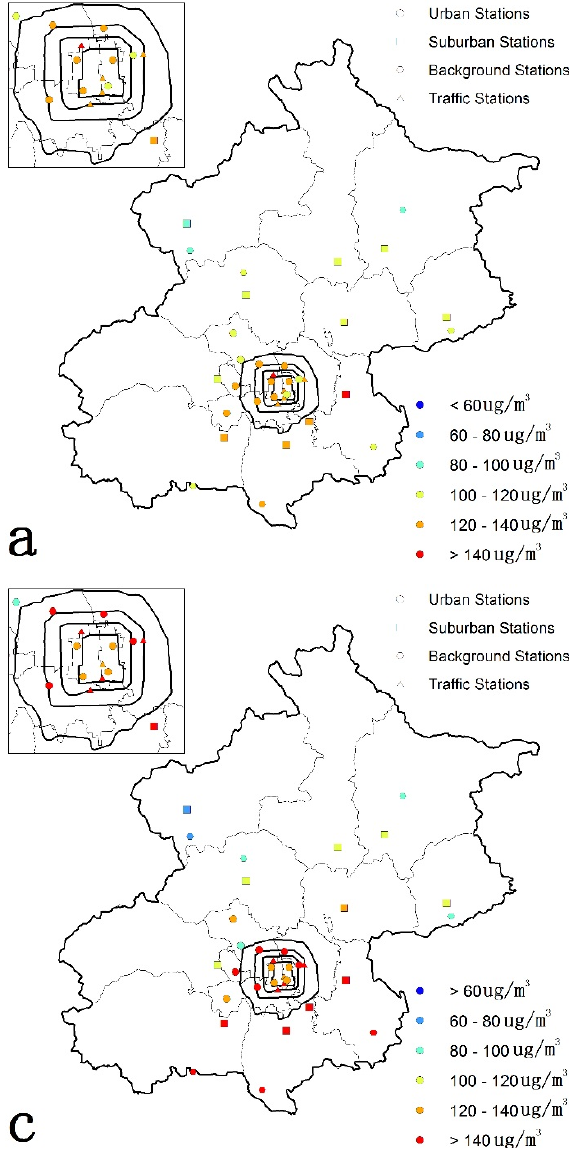
Figure 7. Seasonal variations of PM 10 concentrations for the 35 air quality monitoring stations (( a ) spring; ( b ) summer; ( c ) autumn; ( d )